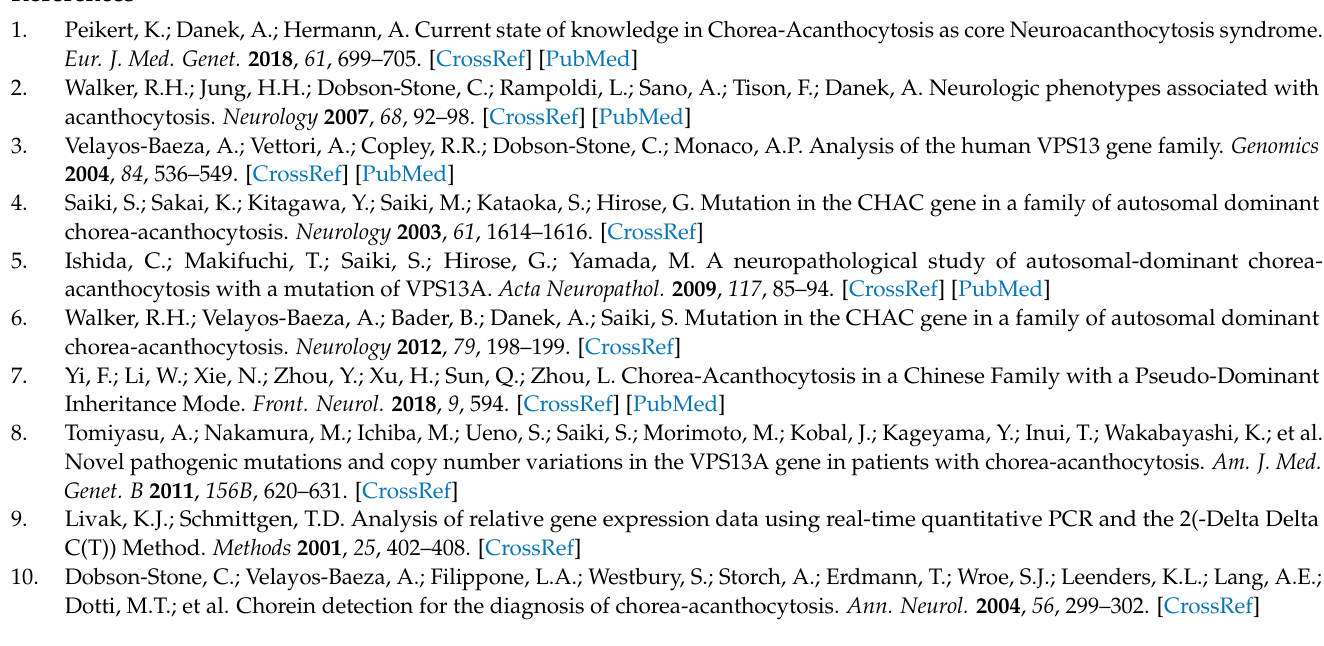
Figure S3: (A) c.1078C>T; (B) c.7867C>T, Figure S4: c.2512+2T>G (homozygous), Figure S5: (A) Table S1. Sequencing primers employed for genetic testing of VPS13A., Table S2. Sequencing primers employed for genetic testing of